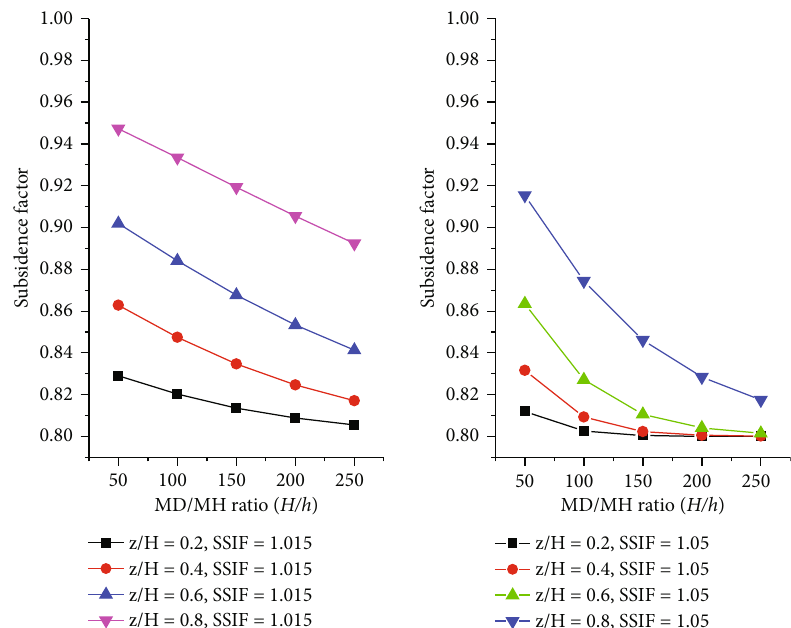
Figure 6: Relation between the subsurface subsidence factor and MD/MH ratio.